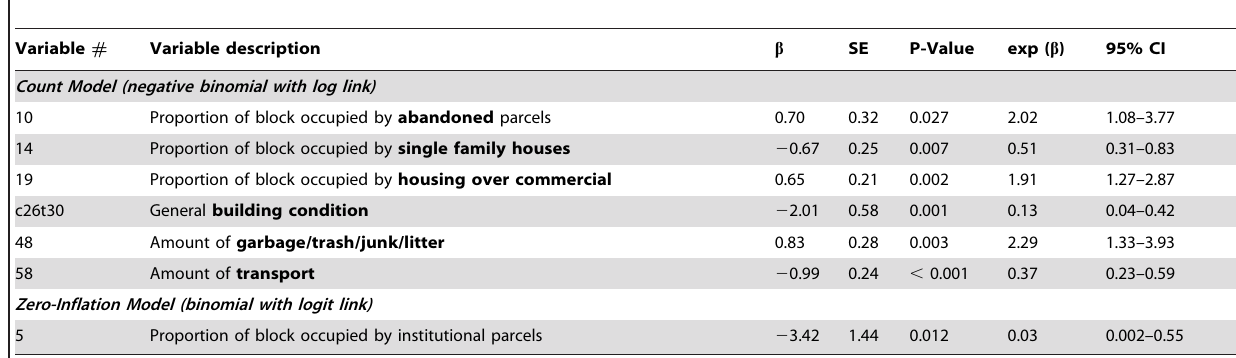
Table 1. Relationship between features of the urban environment and relative abundance of Norway rats ( Rattus norvegicus ).